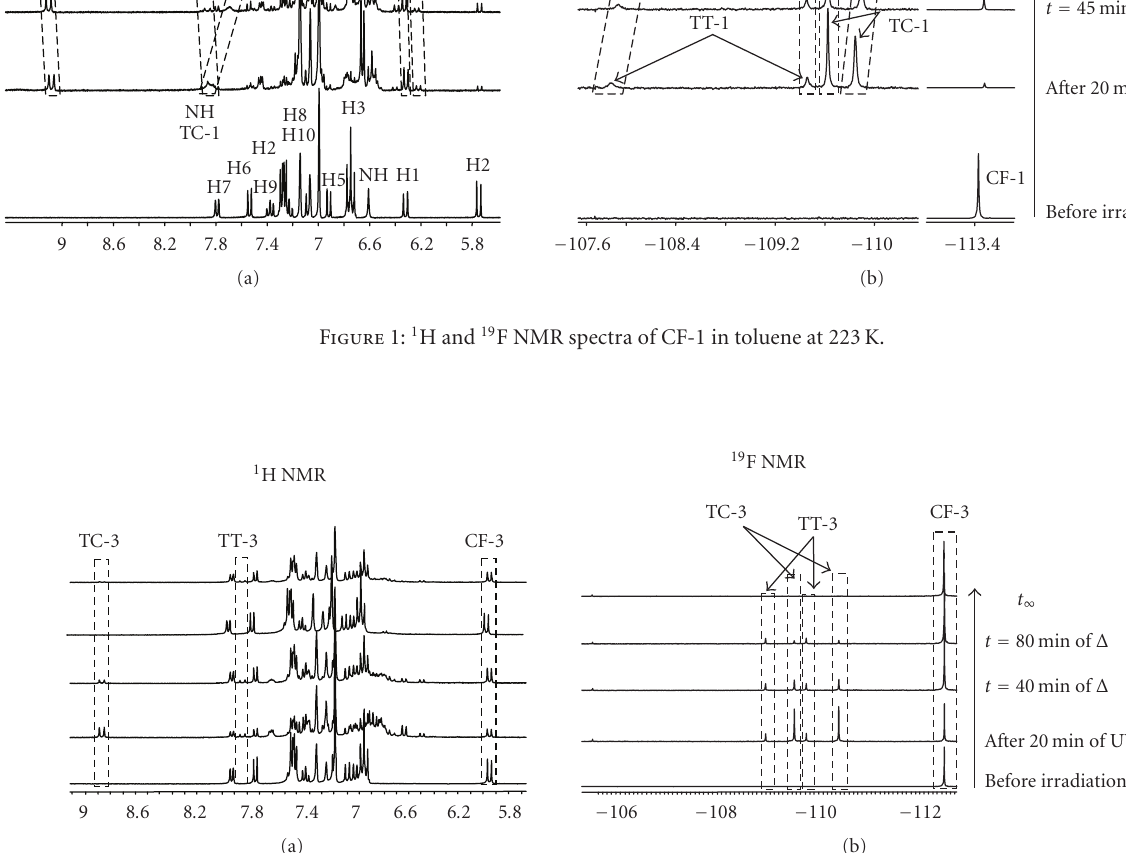
Figure 2: 1 H and 19 F NMR spectra of CF-3 in toluene at 223